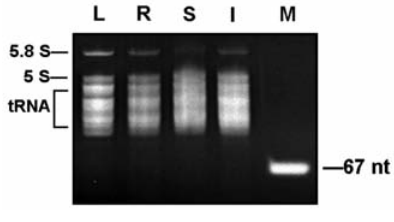
Figure 1. Low-molecular-weight (LMW) RNA (3 (cid:0)g) samples from different Arabidopsis tissues were run on urea (8%) 15% polyacrylamide electrophoresis gels (20 volts/cm, 2 h), and stained with ethid- ium bromide (EB). Lane L, leaf; Lane R, root; Lane S, stem; Lane I, inflorescence; Lane M, 67-nt DNA molecular marker.